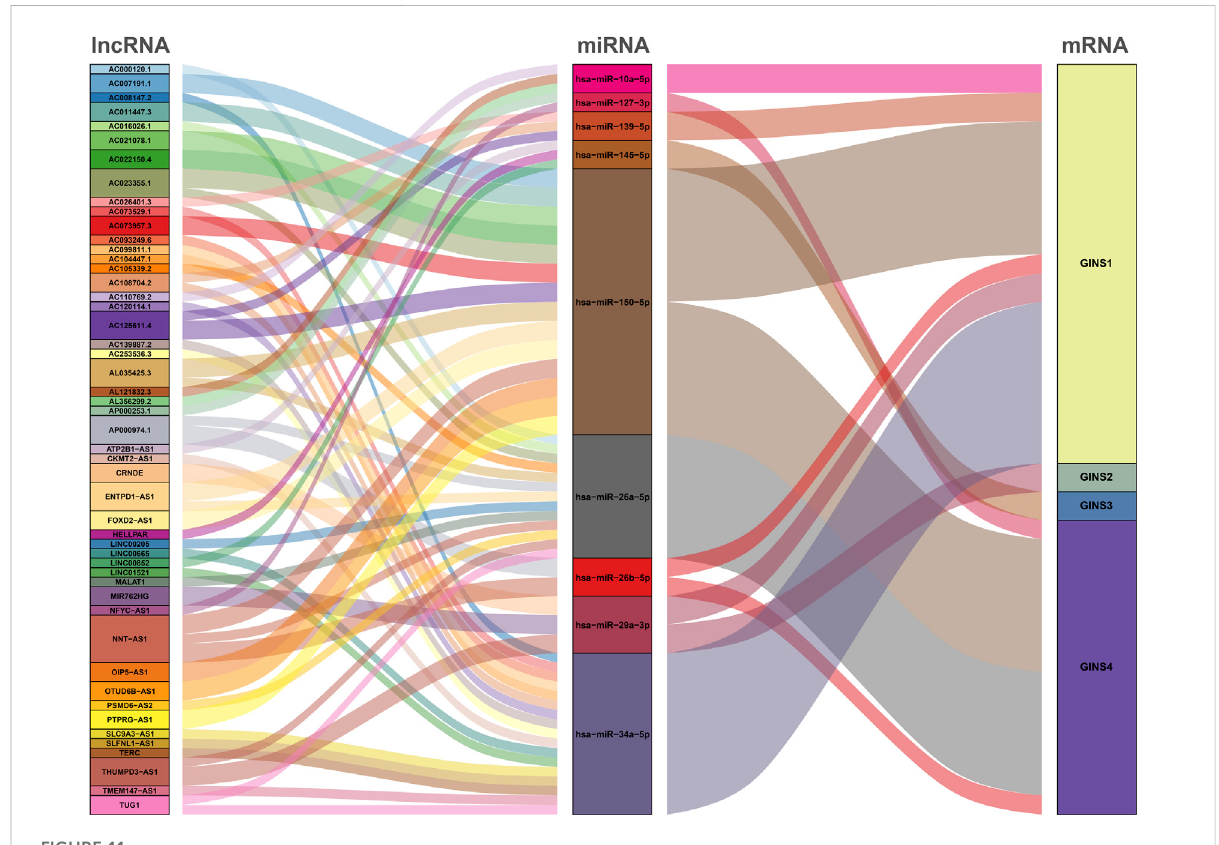
FIGURE 11 Sankey diagram of the ceRNA network targeting GINS1/2/3/4 in SARC.